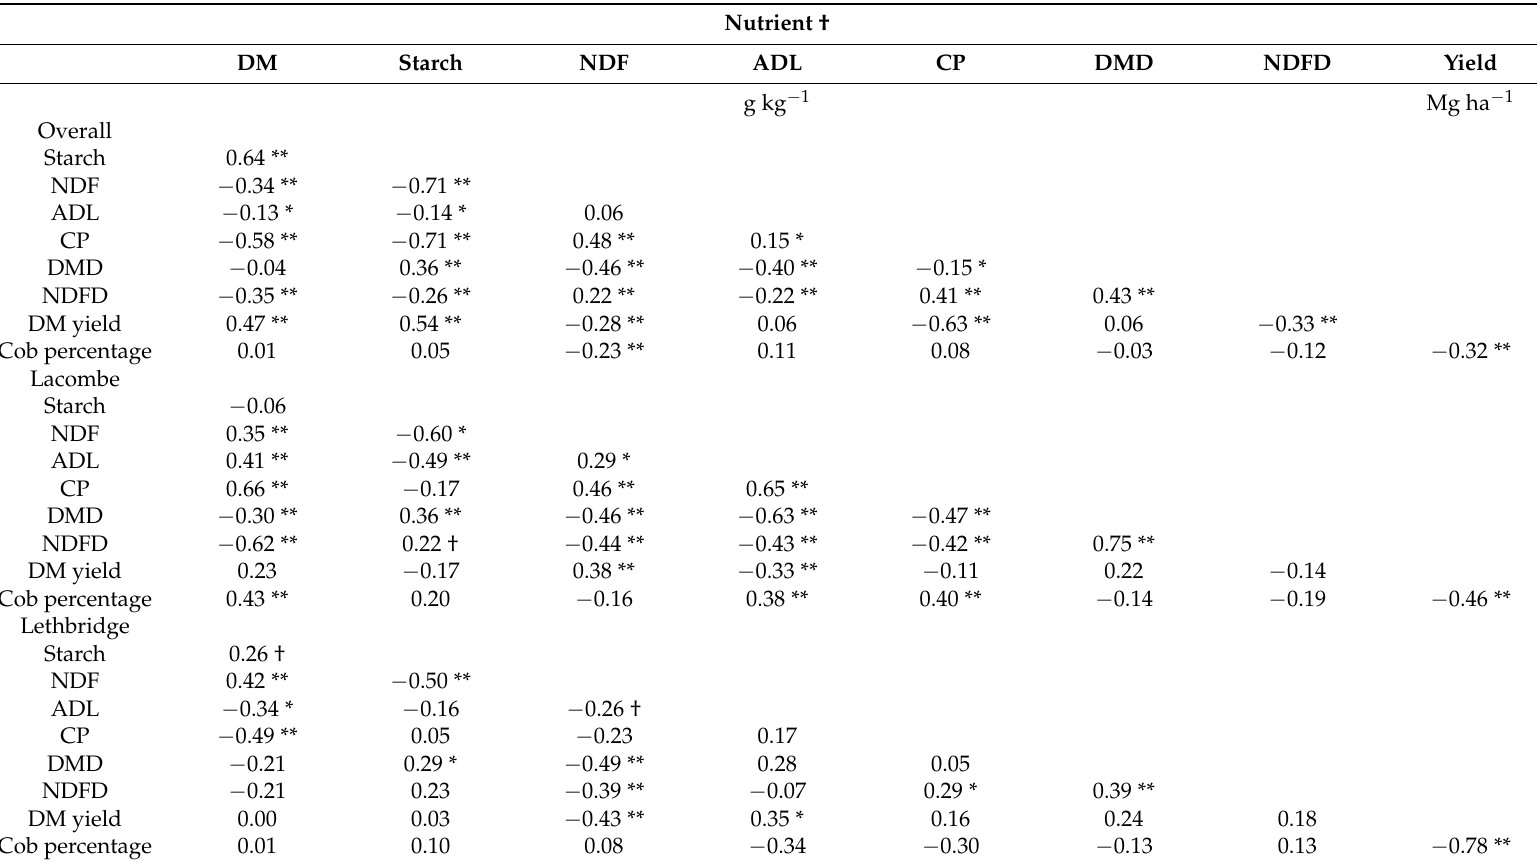
Table 10. Correlation coefficients between nutrients (g kg − 1 ), yield (Mg ha − 1 ), and cob percentage (% DM) of whole-plant corn grown for silage over all locations (Overall) and each location (Lacombe, Lethbridge, Vauxhall, AB; Elm Creek, Manitoba) for corn hybrids grown over three